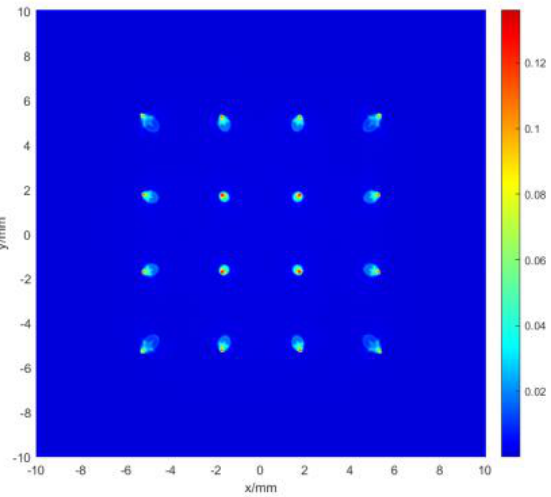
Figure 4. The pattern of image spot at the receiver. Figure 5 represents the relation between the condition number of channel gain matrix and the offset due to the relative offset of the transmitter and receiver in the yoz plane, which is expressed by the condition number of channel gain matrix k = (cid:107) H (cid:107)(cid:107) H − 1 (cid:107) [25]. The condition number of channel gain matrix increases when the relative offset of the transmitter and receiver is increased. When the condition number of channel gain matrix is small, the interference between the receiver signals is also small and can be achieved through direct demodulation. By increasing the degree of link misalignment, we notice an increase in the condition number of channel gain matrix; meanwhile, the interference becomes high, and direct demodulation of the signals cannot be